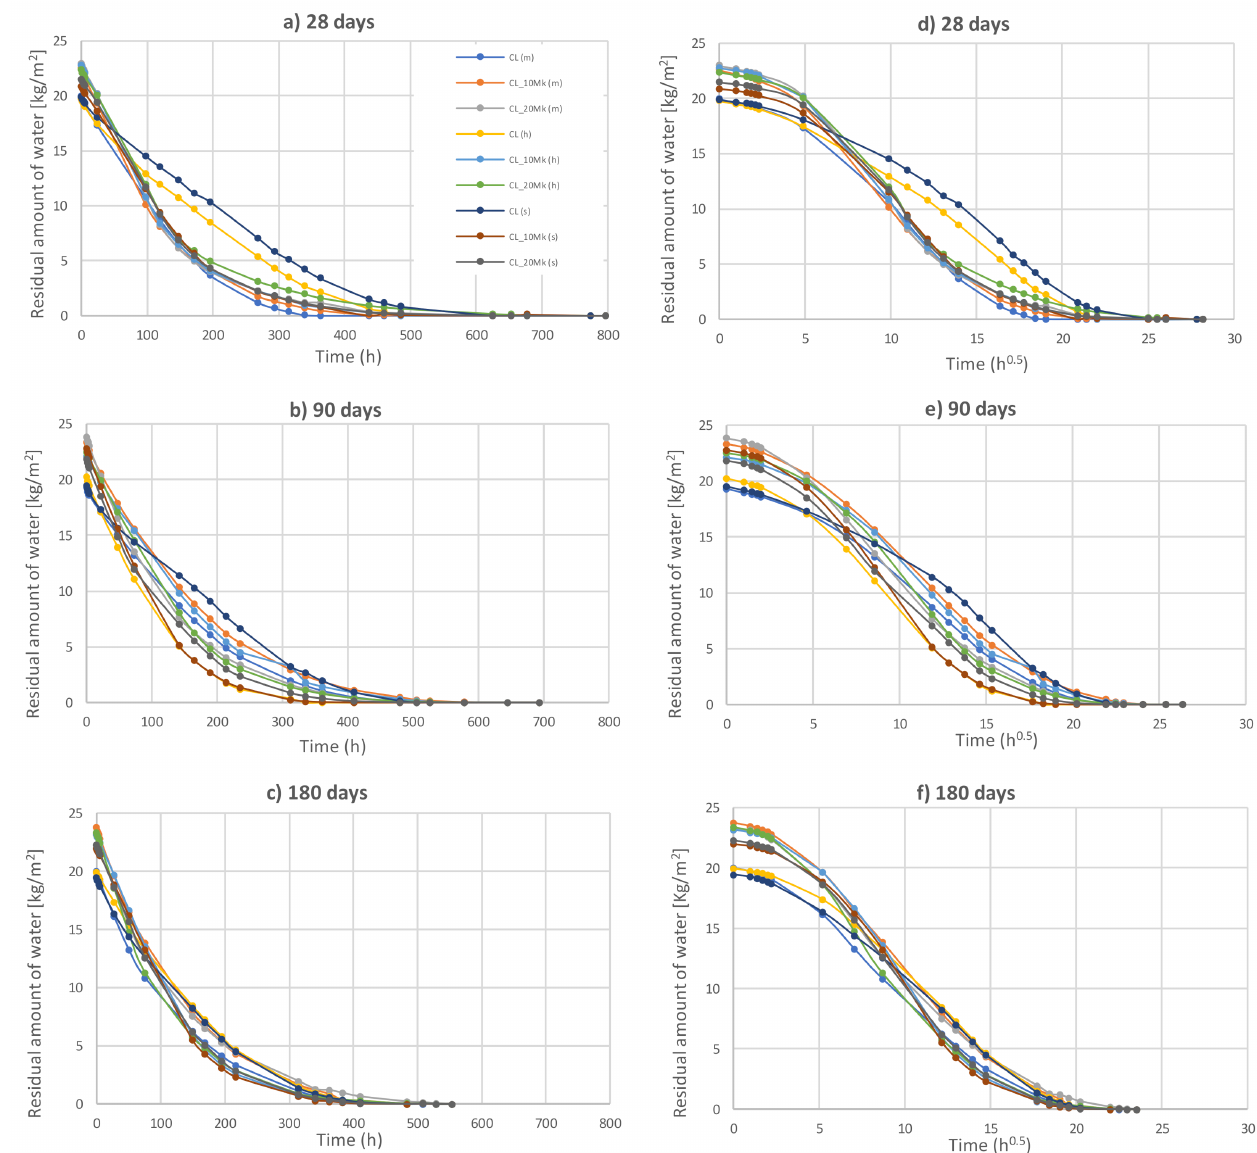
Figure 10. Drying curves of mortars with 0, 10 and 20% Mk replacing air lime, after 28, 90 and 180 days in maritime, humid and standard curing conditions: ( a – c ) by time, showing the initial slope of drying phase 1 at each age; ( d – f ) by square root of time, showing the intermediate slope of drying phase 2 at each